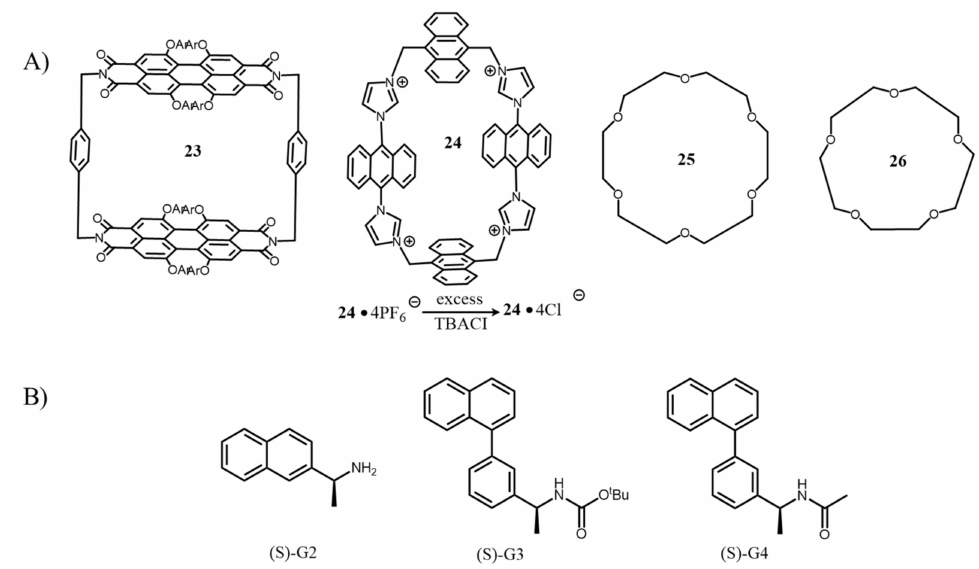
Figure 10. ( A ) Chemical structure of 23 , 24 , 25, and 26 . ( B ) Chemical structure of chiral